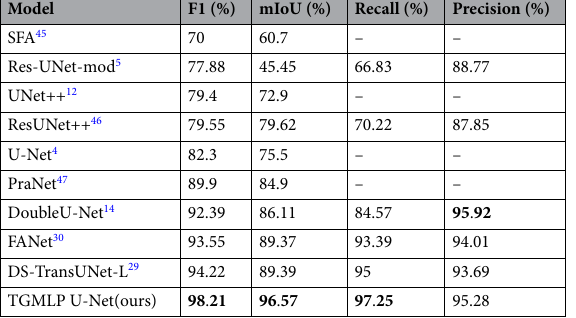
Table 3. Shows the experimental results on Polyp Segmentation DataSet. The best values of each indicator are in bold. (“–” indicates that the codes for calculating Recall and Precision are not provided in the source codes offered by the author).